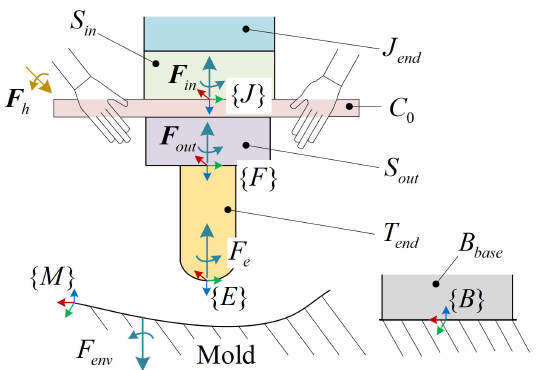
Figure 2. Schematic diagram of demonstration platform. The platform was designed to collect trajectory and force by the kinesthetic